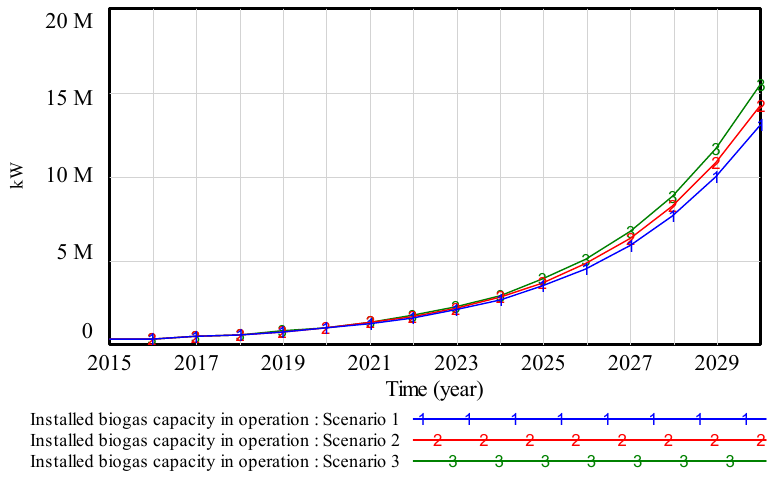
Figure 6. The biogas installed capacity in operation.